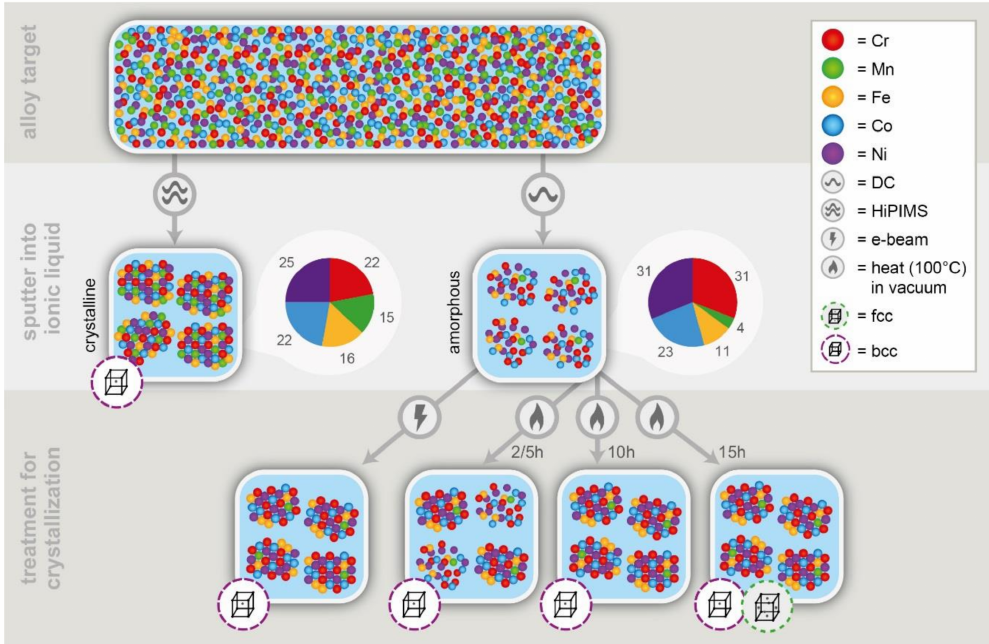
Figure 5. Schematic overview of the different routes used to synthesize amorphous and crystalline multinary NPs. A phase transition from bcc to fcc NPs occurs for ex situ heating at 100 ◦ C within 15h. Crystalline NPs are obtained by the electron beam and annealing treatment or the HiPIMS